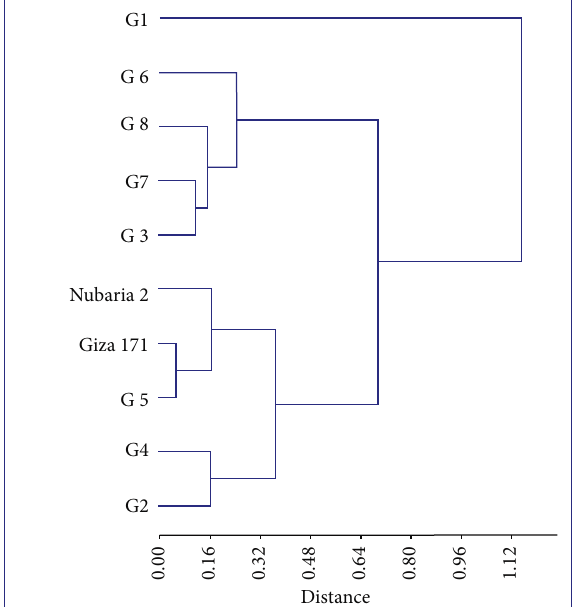
Figure 1: Correlation between drought tolerance indices with grain yield under normal irrigation and drought stress conditions. Table 8: Summary of hierarchical cluster analysis represents the classification of tested ten wheat genotypes based on grain yield under normal and stress tolerance